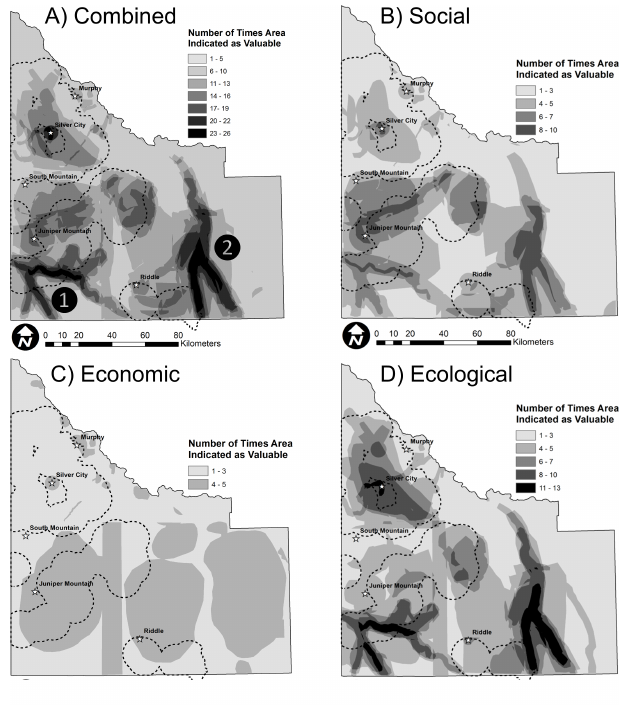
Fig. 4. Frequency of the polygons derived for all values combined (A), social values (B), economic values (C), and ecological values (D) in Owyhee County, Idaho, USA. Dotted lines indicate the proposed project boundary for the Bruneau- Owyhee Sage-Grouse Habitat project. Points 1 and 2 in (A) indicate the Owyhee and Bruneau-Jarbidge watersheds and associated wilderness